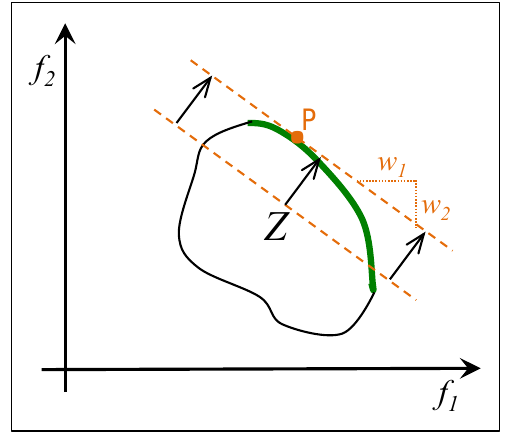
Figure 2. By using appropriate weights, every point of a convex Pareto front can be achieved by the weighted sum. Here, point P can be obtained for the weights w The arrows show the movement direction of points where the largest quality gain is obtained.